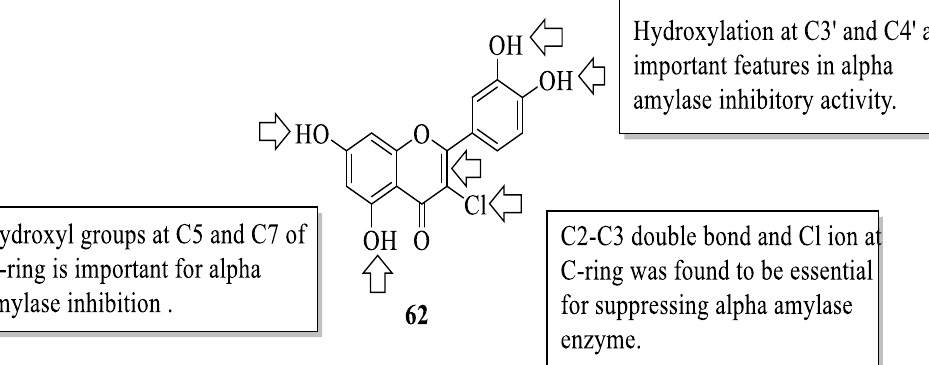
Figure 18. The SAR of flavonoids for α -amylase inhibition activity [55]. Next, Jia et al. studied several dietary flavonoids for their α -glucosidase inhibitory and insulin-sensitizing potentials [56]. For α -glucosidase inhibition, 27 dietary flavonoids were tested against a positive control, acarbose. The results revealed that three